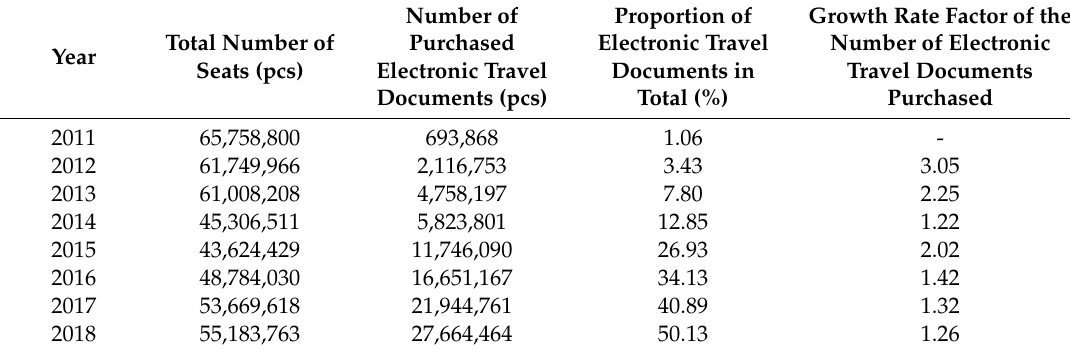
Table 1. Dynamics of indicators of issued and purchased electronic travel documents at the JSC